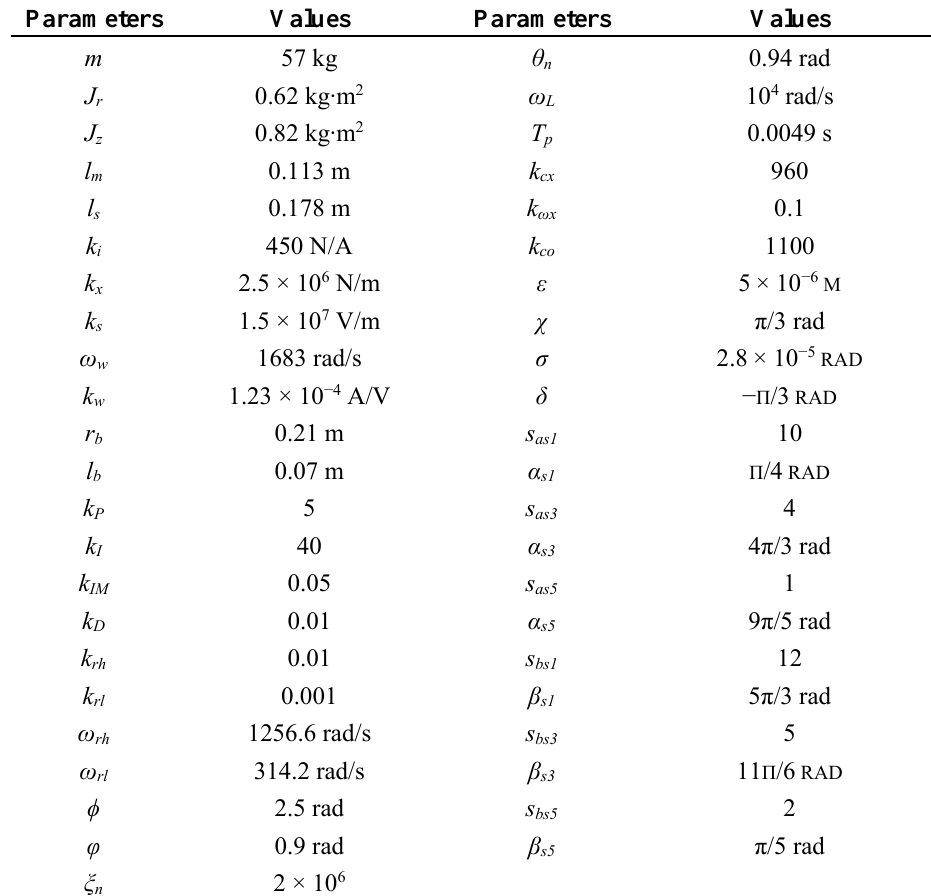
Figure 12. The photograph of the magnetically-suspended control moment gyro experimental rig. Table 1. Parameters of the AMB system with the proposed control approach. Parameters Values